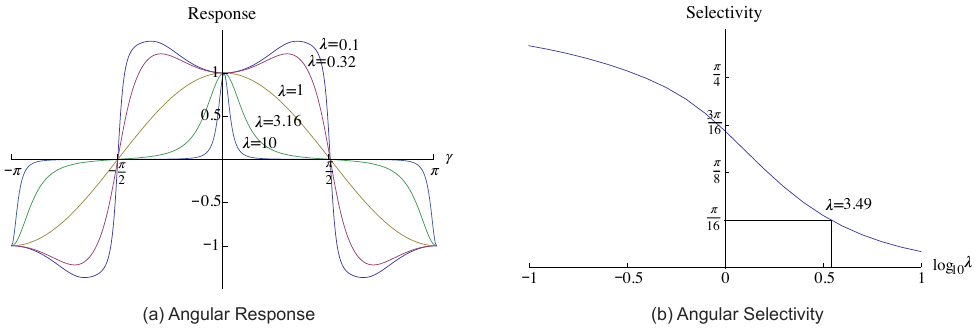
Figure 4. Angular response of FDOG for different aspect ratio λ